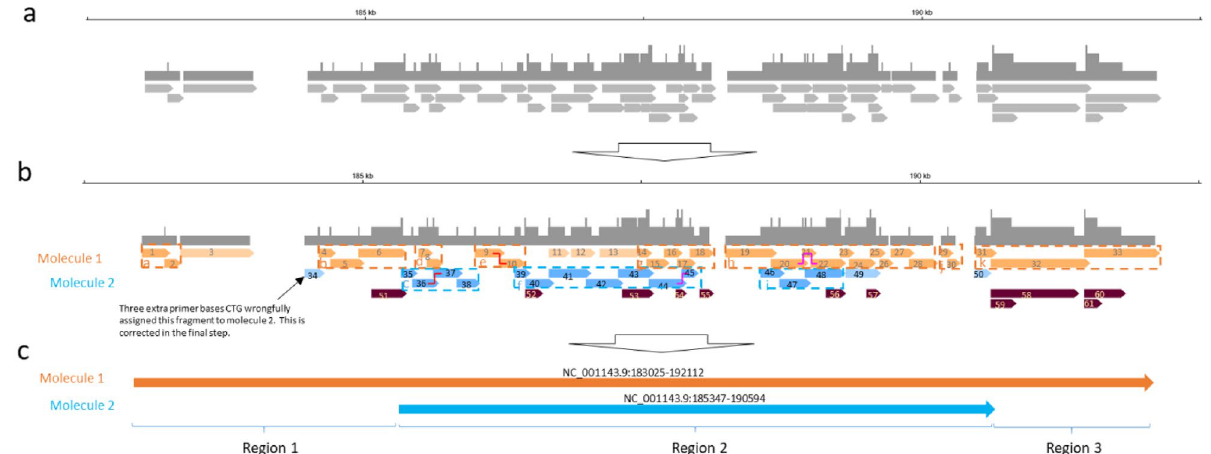
Figure 4. The BIGseq algorithm to identify two molecules. ( a ) Boundary of an archipelago is set. ( b ) Two molecules and redundant fragments are called. ( c ) Final presentation of two molecules. The graphs were generated with Microsoft PowerPoint and IGV (https:// softw are. broad insti tute. org/ softw are/